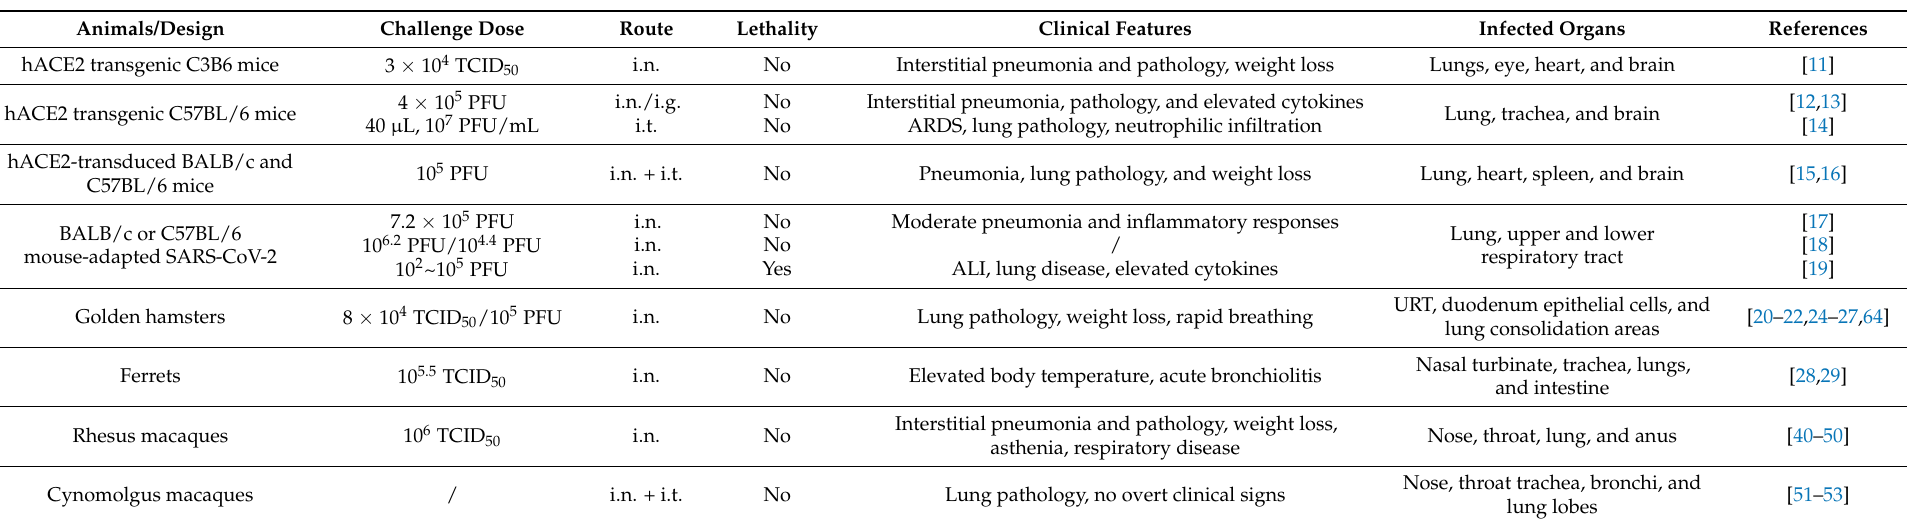
Table 1. Characterizations of animal models for